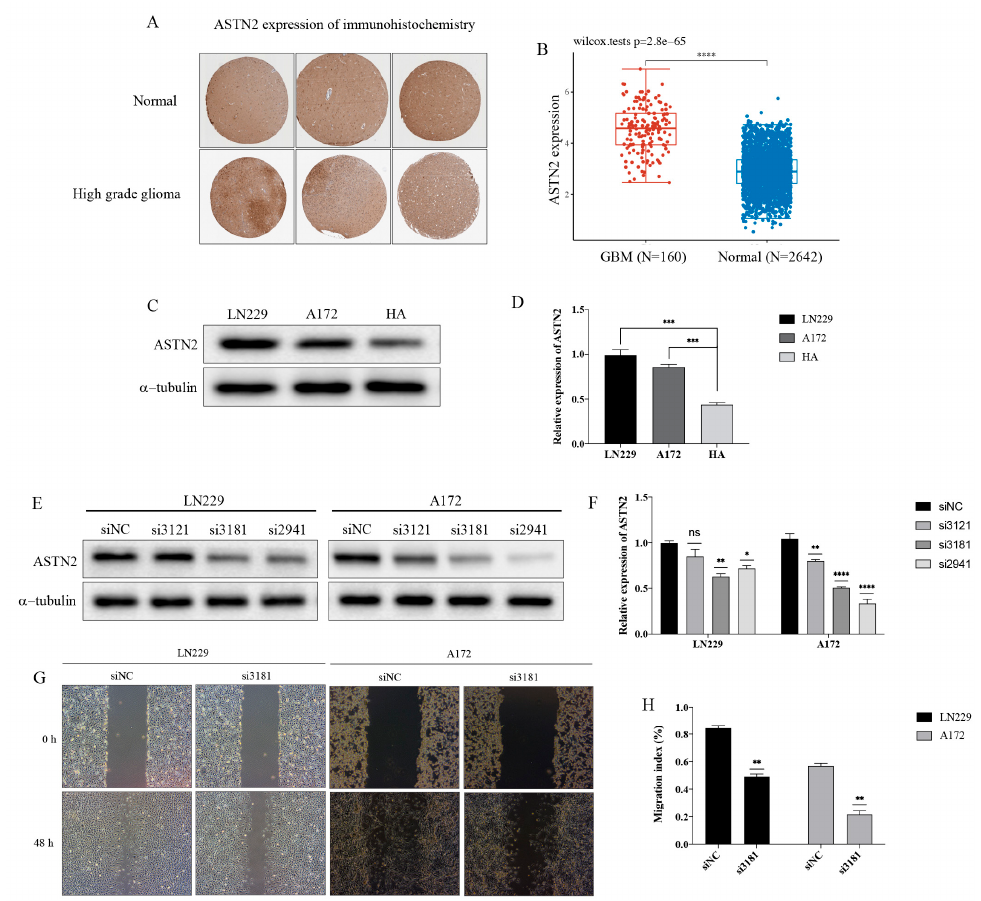
Figure 11. ASTN2 increases the migration ability of GBM cells . ( A ) ASTN2 is not specific for GBM and is also expressed moderately in normal glial cells. ( B ) Bioinformatic analysis shows that the expression of ASTN2 in GBM is significantly higher than that in normal brain tissue. ( C ) and ( D ) Western blot results show that the expressions of ASTN2 in GBM lines are significantly higher than that in HA. ( E ) and ( F ) Effects of ASTN2 siRNAs on down-regulation of ASTN2. The results show that si3181 and si2941 are effective in both LN229 and A172 cell lines, and the effect of si3181 is relatively stable. ( G ) and ( H ) Wound healing assay shows that control group cells healed the wound to a greater extent than the ASTN2 inter- ference group cells after 48h. **** p < 0.0001, *** p < 0.001, ** p < 0.01, * p <0 .05